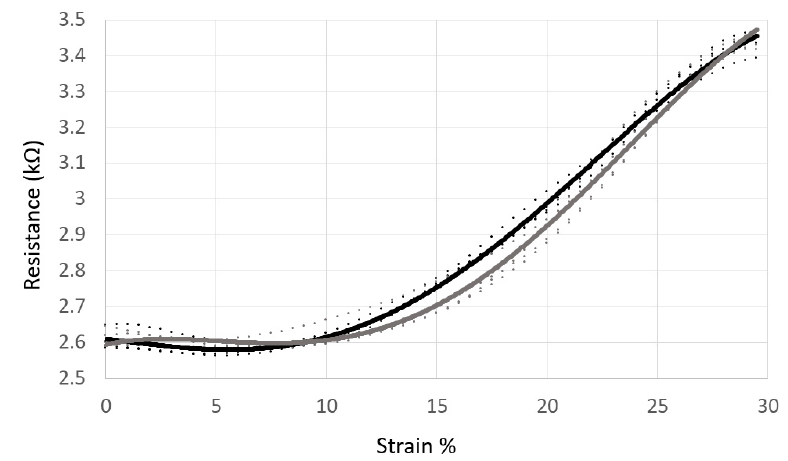
Figure 2. Conductive paint resistance vs strain graph, cycles 123–126 of 250 cycles. Dotted lines represent raw data with a 4th degree polynomial trendline for elongations (black line) and retractions (grey line) .